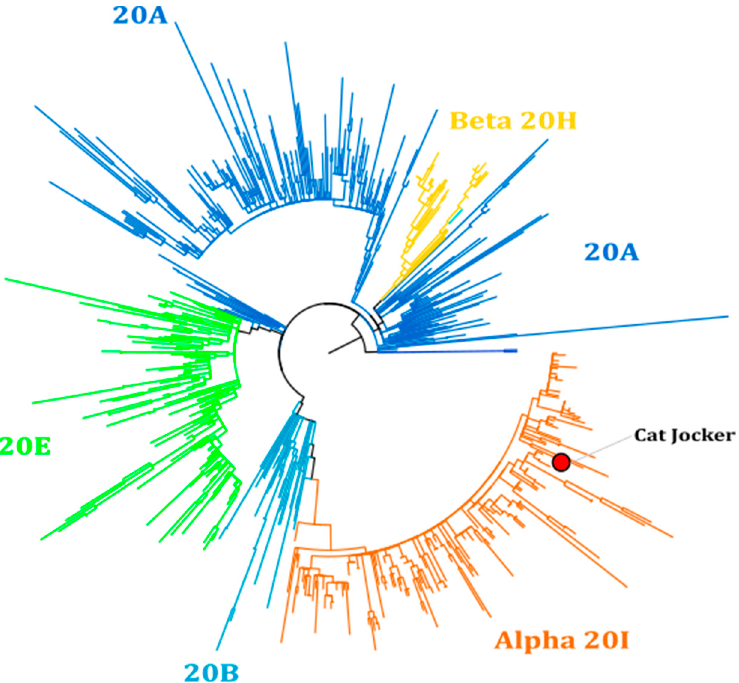
Figure 3. Phylogenic analysis of SARS-CoV-2 genomes, rooted with 4 genomes from the early epidemic and including a representative selection (over 700 genomes) of the diversity of major lineages